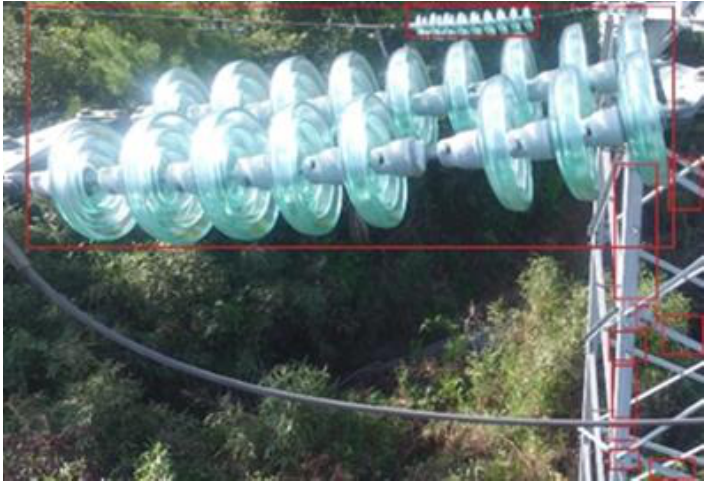
Figure 4. Generation of the minimum bounding box of the feature area .